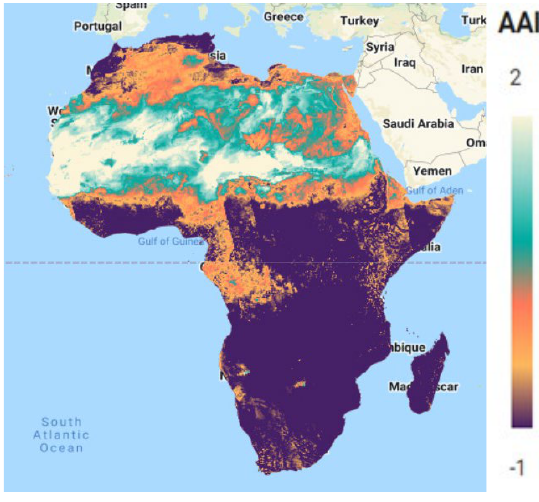
Fig. 3 . Aerosol movement from 4 th – 6 th June of 2020 By the 7 th to 9 th of June, the dust extended to Western Sahara, Mali, Niger, Mauritania, Southern Algeria, and Chad mostly with an AAI of 2.